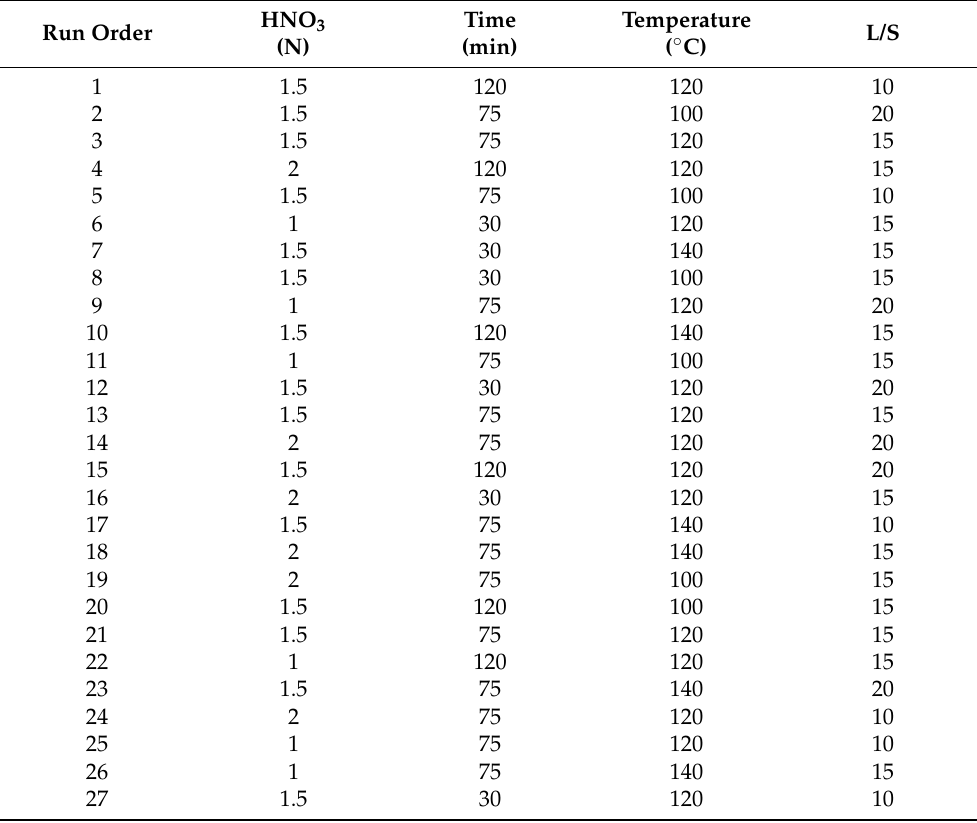
Table 4. Response surface methodology with a Box–Behnken experimental design. Run